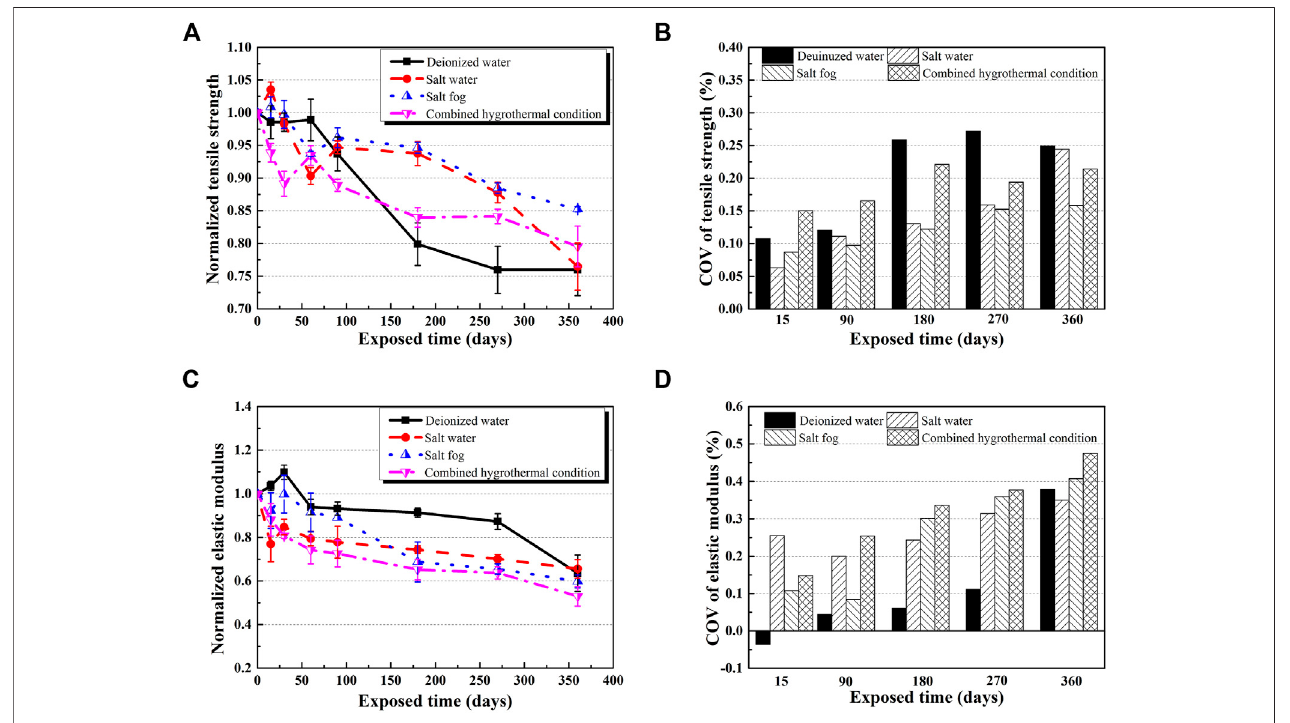
FIGURE 5 | Normalized tensile properties and COV of UP GFRP exposed to different conditions: (A) normalized strength, (B) COV of tensile strength, (C) normalized elastic modulus, and (D) COV of elastic modulus.